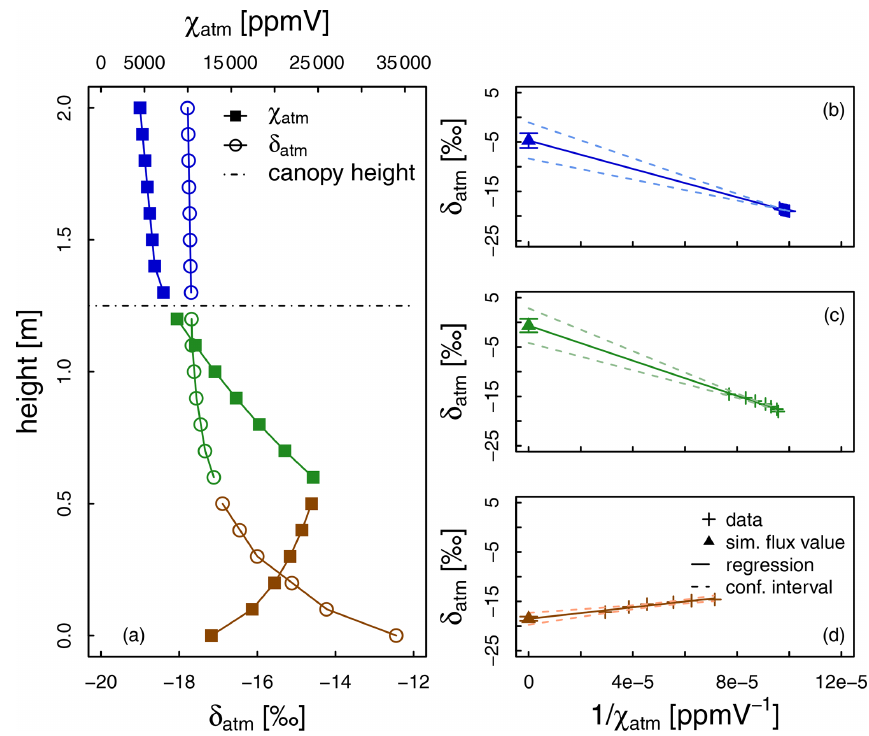
Figure 6. One example of application of the Keeling (1958) plot technique to synthetic data that would be collected with a field-deployable lift at high vertical resolution (0.1m) (for implications on measurement frequency, which also needs to be high ( ≥ 5Hz), see Sects. 3.1 and 4 of Ney and Graf, 2018). The oxygen isotopic compositions of evapotranspiration, transpiration, and evaporation are estimated by the values of the y intercepts of the linear regressions between the isotopic composition of the atmospheric water vapour ( δ atm ) and the inverse of the water vapour mixing ratio ( χ atm ) in three non-overlapping regions, i.e. (i) the “free atmosphere” (indicated by the blue symbols), (ii) the region spreading from the canopy height to the height of the local maximum in δ atm (green symbols), and (iii) the region delimited by the δ atm local maximum height and the ground level (brown symbols). Also shown are the 95% confidence interval envelopes of the linear regressions (dashed lines) as well as error bars (1 standard error) of the y